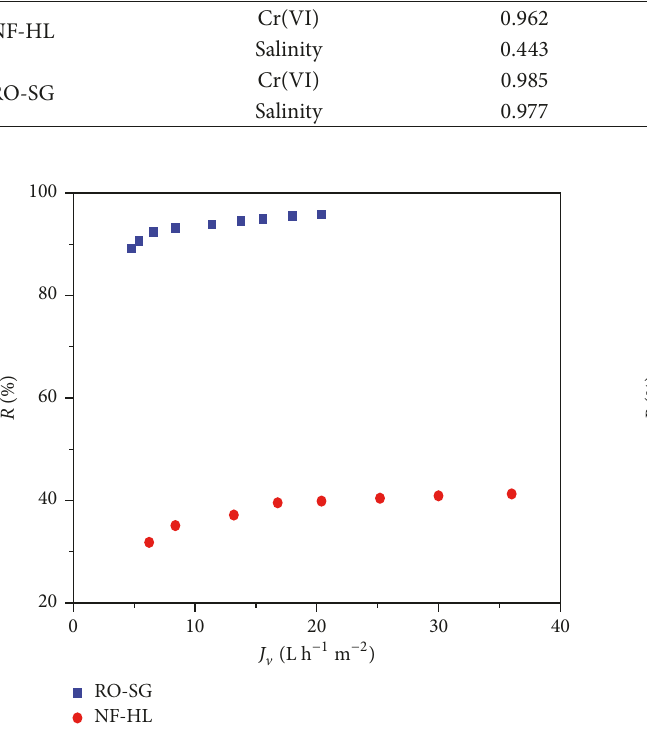
Figure 8: Total salinity rejection during wastewater treatment by NF-HL and RO-SG membranes, pH = 8, 𝑌 = 50%, and 𝜃 = 25 ∘ C.